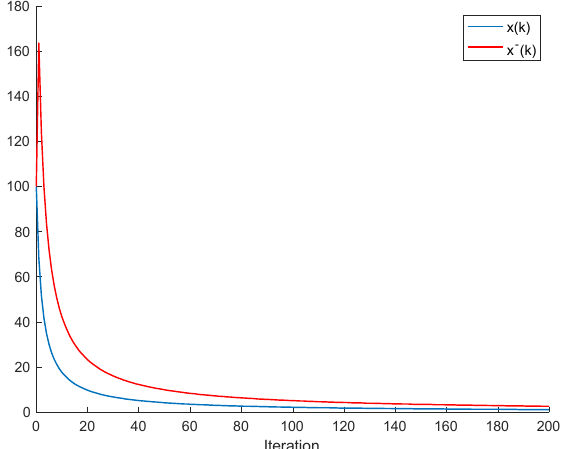
Figure 4. Evolution of x ( k ) for constant parameters in Example 3, while no harvesting nor independent consumption is considered.